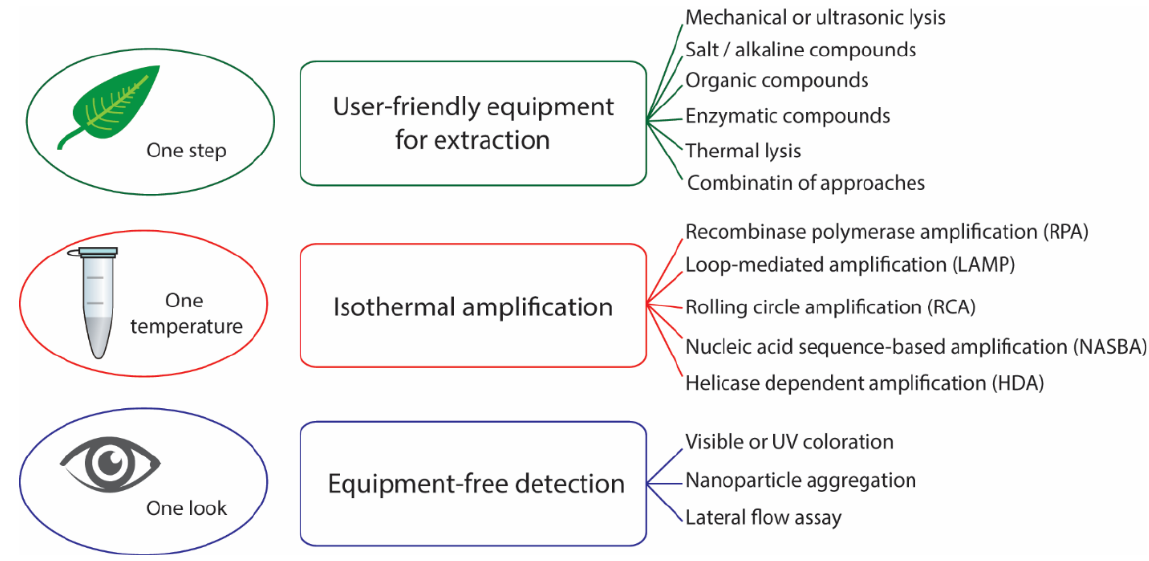
Figure 1. The main kinds of extraction, isothermal amplification, and amplicon detection for rapid, sensitive, and in-field diagnostics testing of viral and other plant pathogens.